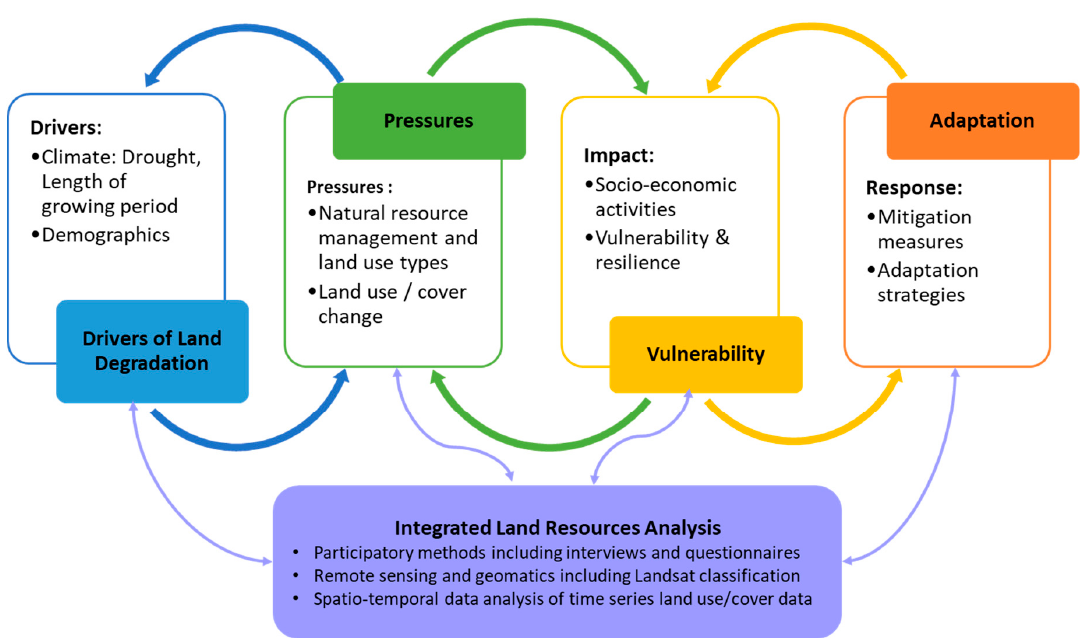
Figure 1. Methodological framework combining elements from Driver–Pressure–State–Impact– Response (DPSIR) [36], chain of risk [37], integrated land resource analysis [38,39], and vulnerability assessment [28].